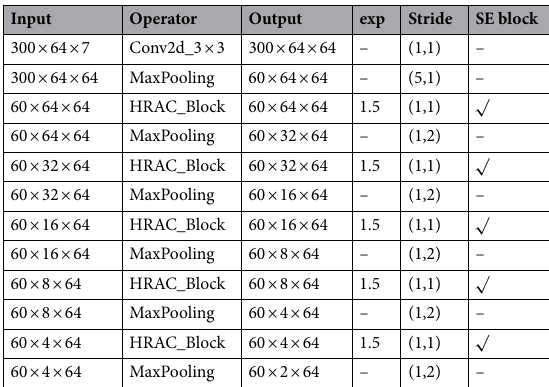
Table 7. The overview of RACNN used in SELD.